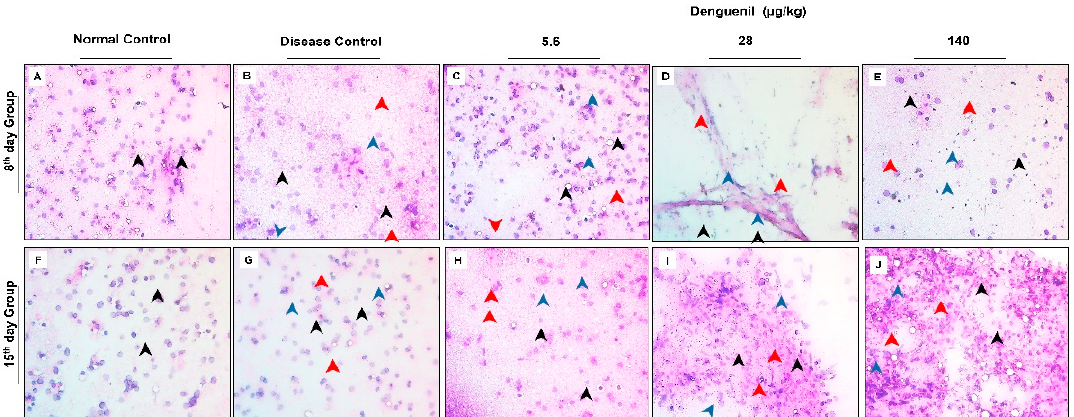
Figure2. Smearpathologyexaminationoflivershowingtheprotectivee ff ectofDenguenil. Hematoxylin and eosin (H&E) staining and analysis was performed on liver smears from di ff erent groups containing various doses to assess the anatomy and cellular damage upon DENV-3 infection, and protective e ff ect of Denguenil on cellular phenotypes. ( A , F ) Normal Control. ( B , G ) Disease Control. ( C , H ) 5.6 µ g / kg Denguenil. ( D , I ) 28 µ g / kg Denguenil. ( E ) 140 µ g / kg Denguenil, 8th day group. ( J ) 140 µ g / kg Denguenil, 15th day group. Black arrowheads indicate normal and intact cells; red arrowheads indicate necrotic cells, and blue arrowheads indicate inflammatory cells. Representative images from each group (n = 24) are shown. Original magnification, 40 ×